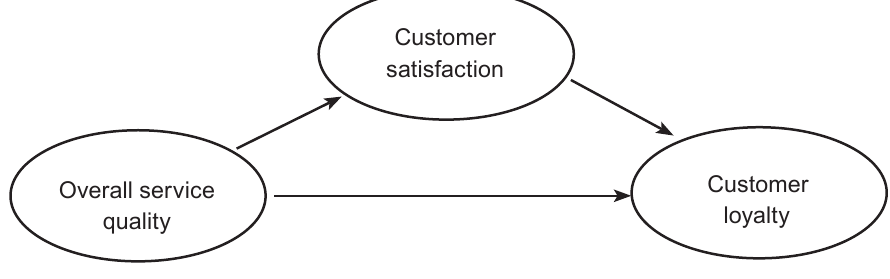
Fig. 1 - Research model (Source: Own